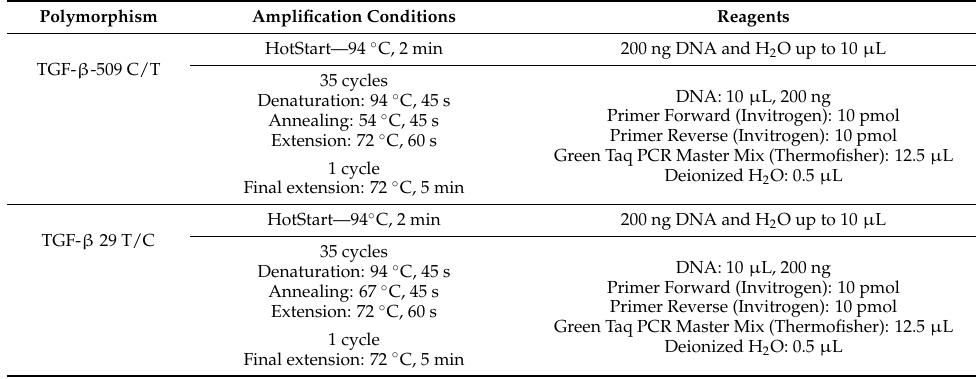
Table 11. Amplification conditions and reagents for TGF- β polymorphisms.